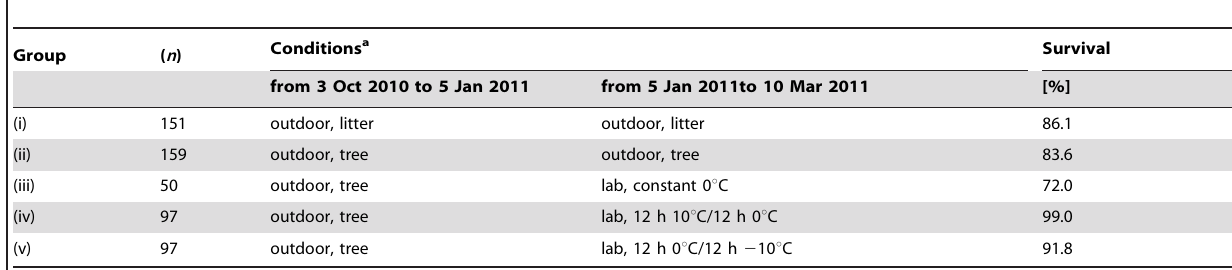
Table 3. Winter survival in caterpillars of Cydia pomonella exposed to semi-natural conditions.